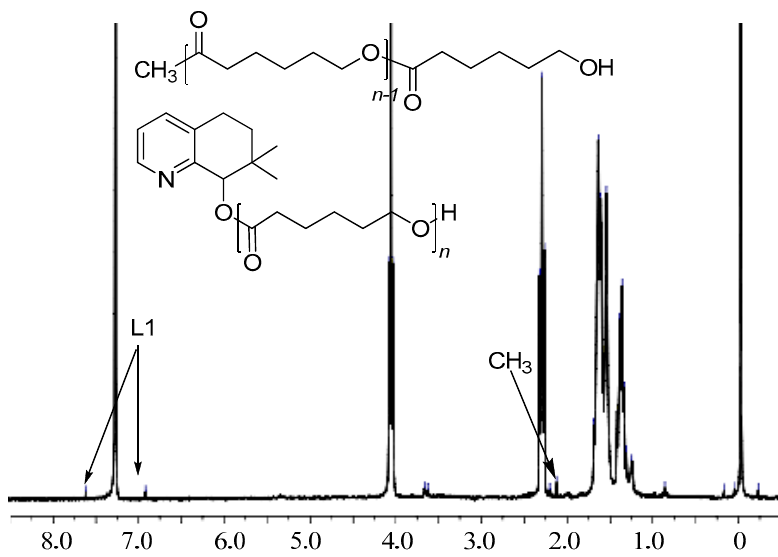
Figure 4. The 1 H NMR spectrum of the PCL obtained using C1 as initiator (run 13, Table 3).